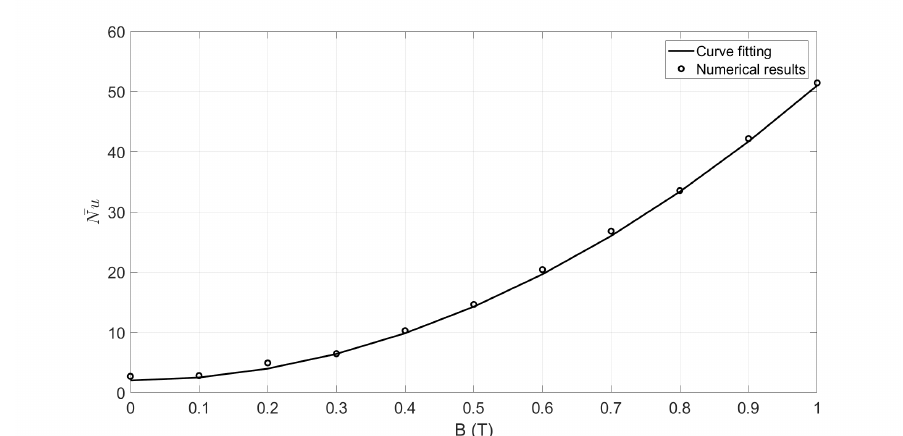
Figure 9. Bubble growth profiles.